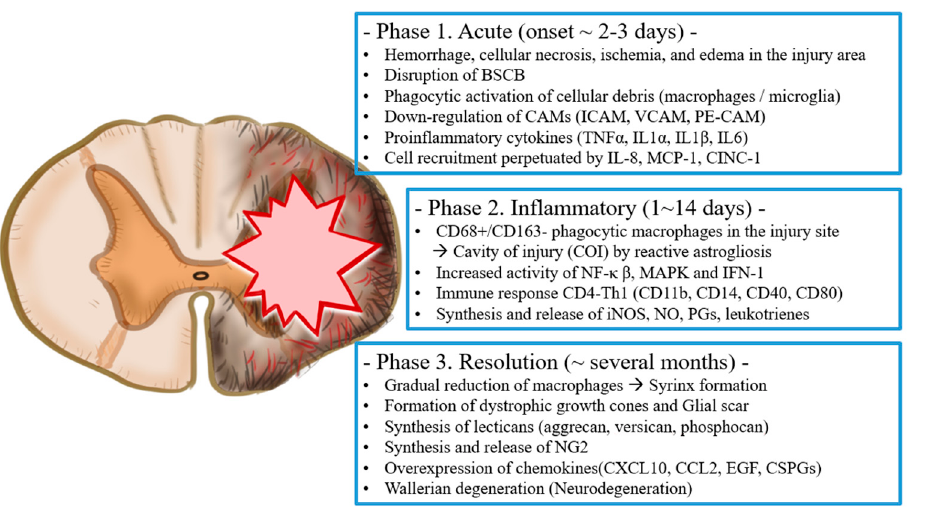
Figure 1. Schematic diagram for damage stages and responses in spinal cord